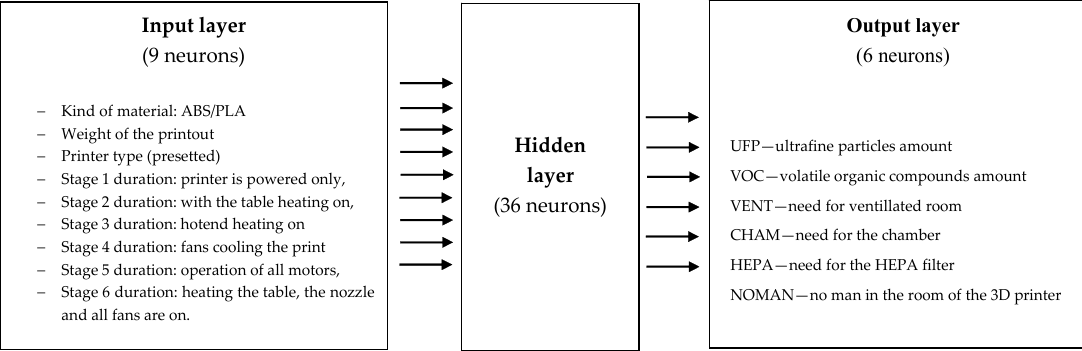
Figure 2. Artificial neural network 2 (ANN2) optimal structure for air pollution assessment structure: inputs and outputs.